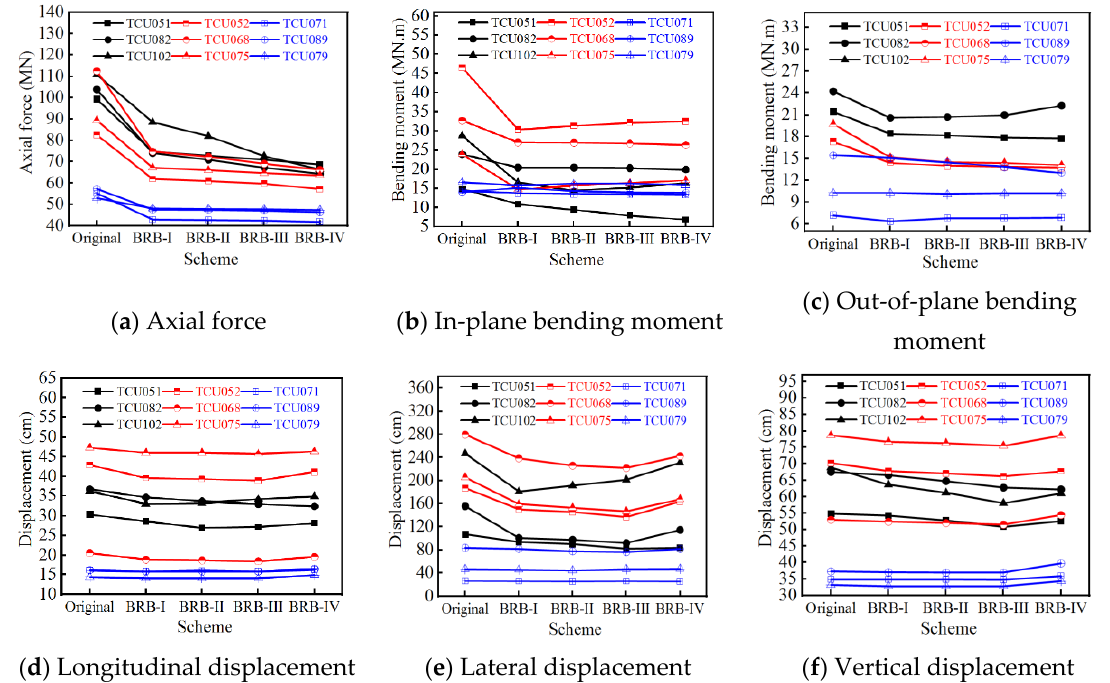
Figure 13. The seismic mitigation effect of BRBs on the internal force and displacement of arch rib.